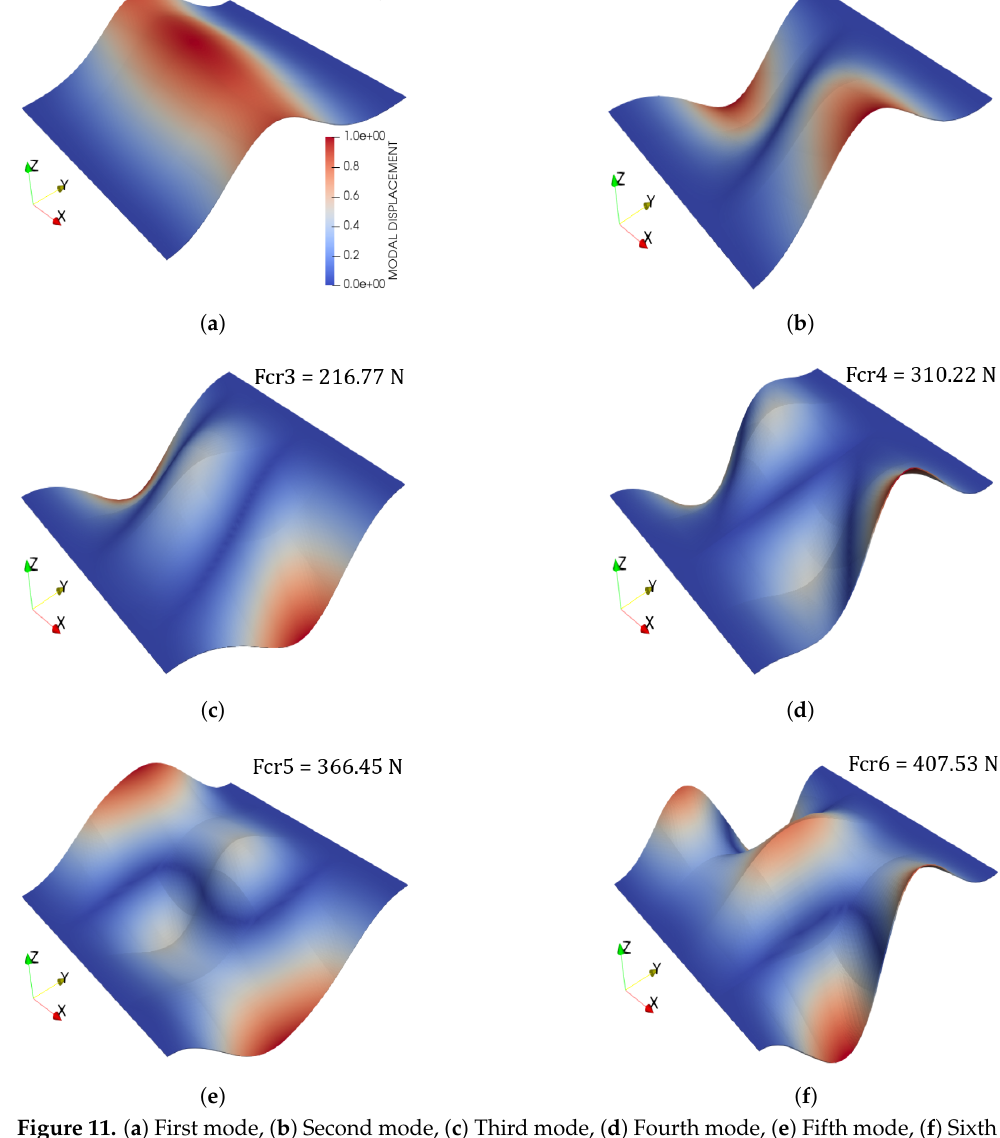
Figure 11. ( a ) First mode, ( b ) Second mode, ( c ) Third mode, ( d ) Fourth mode, ( e ) Fifth mode, ( f ) Sixth mode. Case 1 pristine buckling modes. A uniform fibre volume V f = 0.60 is considered and no fibre waviness. The colour bar in ( a ) applies for all figures in this